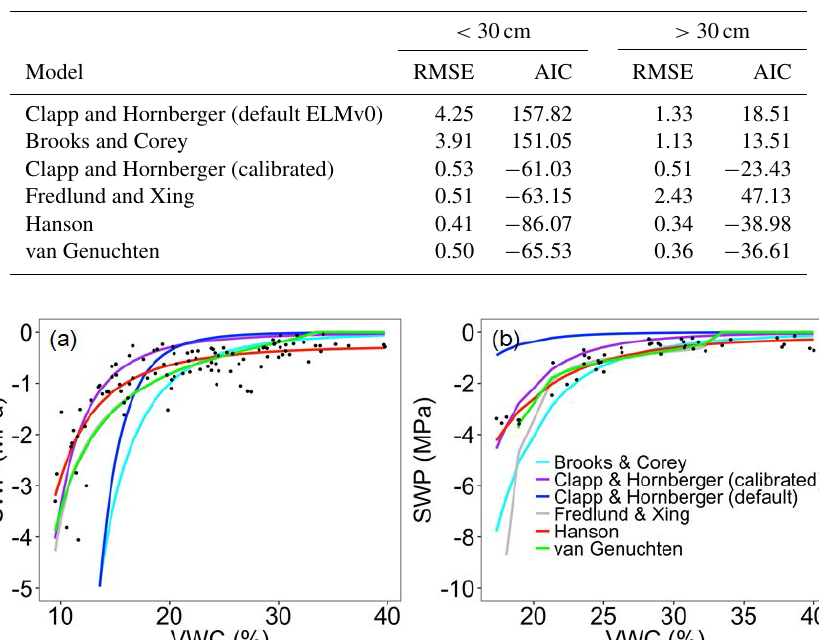
Table 1. Root mean square error (RMSE) and Akaike information criterion (AIC) of different models in simulating the SWP–VWC relation- ship for the soil in the MOFLUX site at two depths: 0 to 30cm and below 30cm.